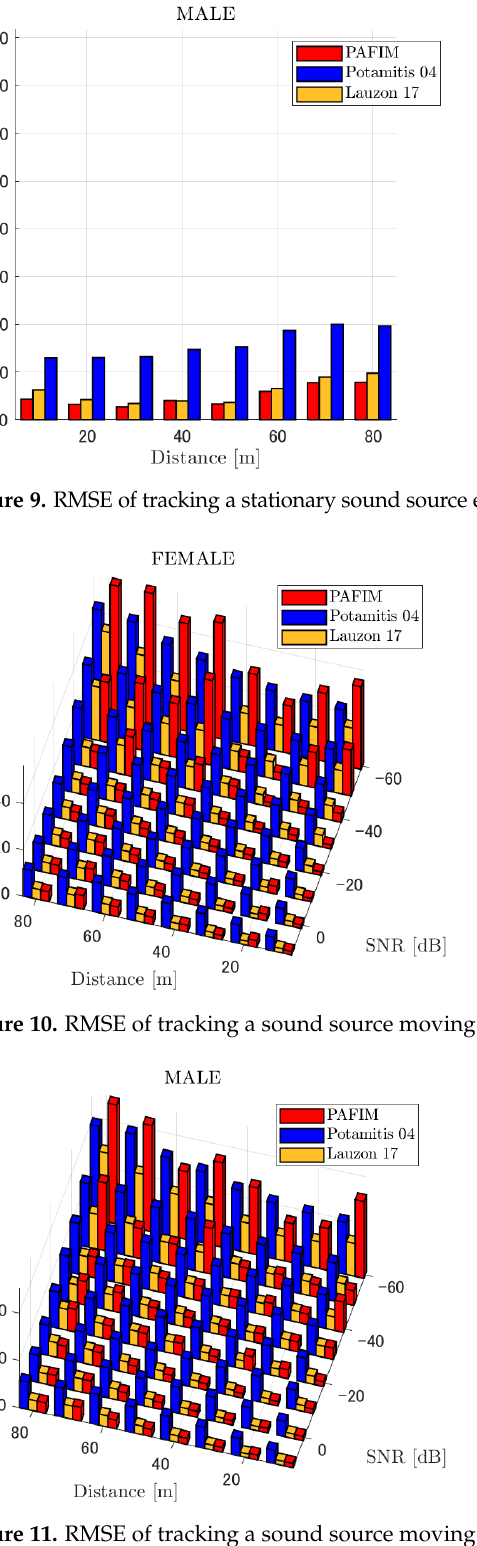
Figure 11. RMSE of tracking a sound source moving in a circle emitting male